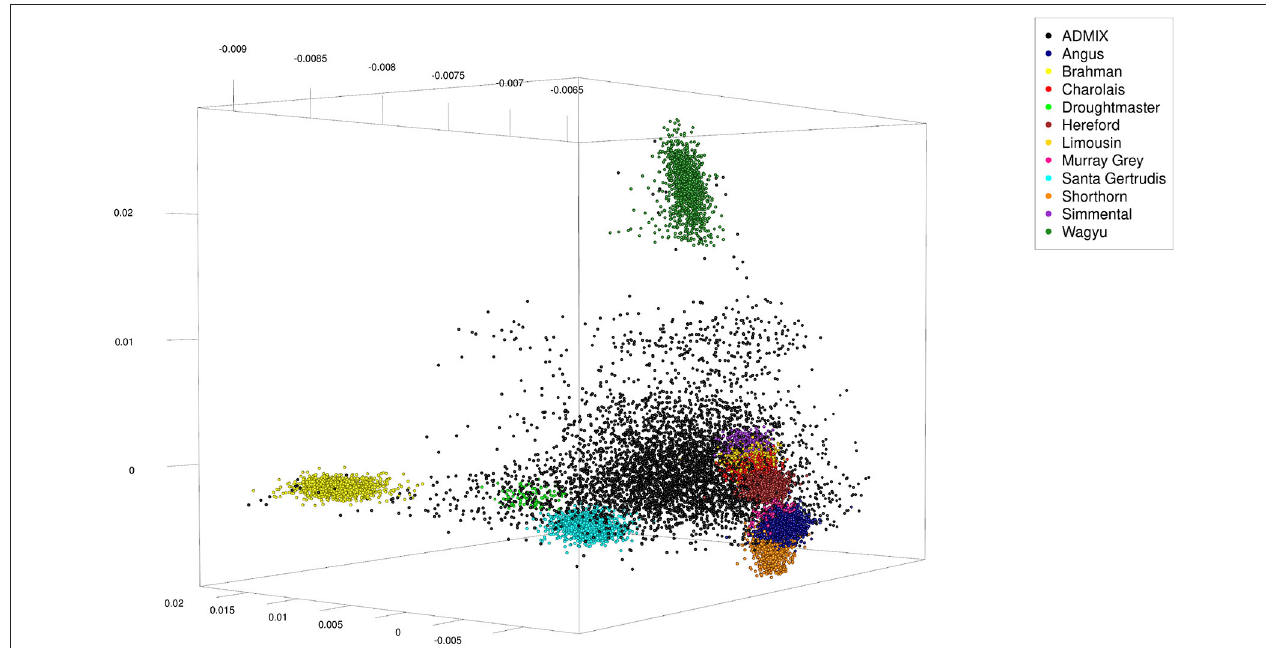
FIGURE 1 | First three principal components of artificially admixed (black spheres) and non-admixed (colored spheres) animals of the cattle data set obtained from a singular value decomposition of a genetic marker matrix of dimension 16,639 (number of genotypes) by 4,022 (number of markers). The genotype sample consisted of 5,000 artificially admixed and 11,639 original